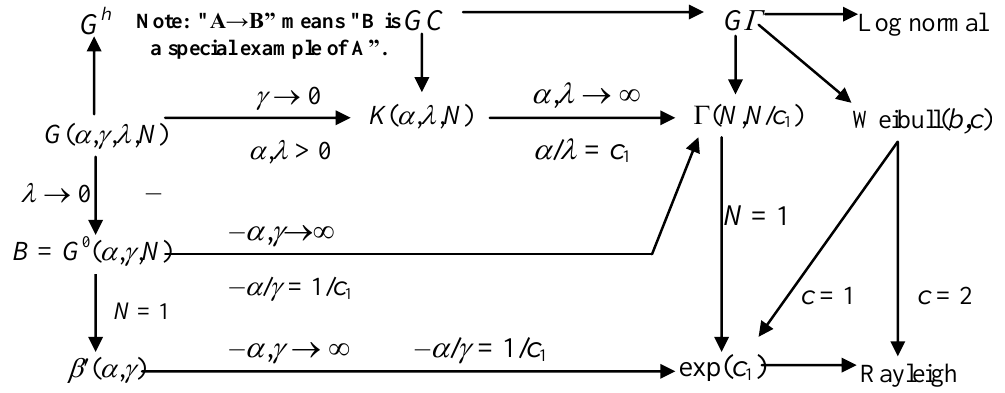
Figure 7. The concrete expressions of various distributions can be seen in [2,19]. Figure 7. Relationship among the major statistical models ( N is the look